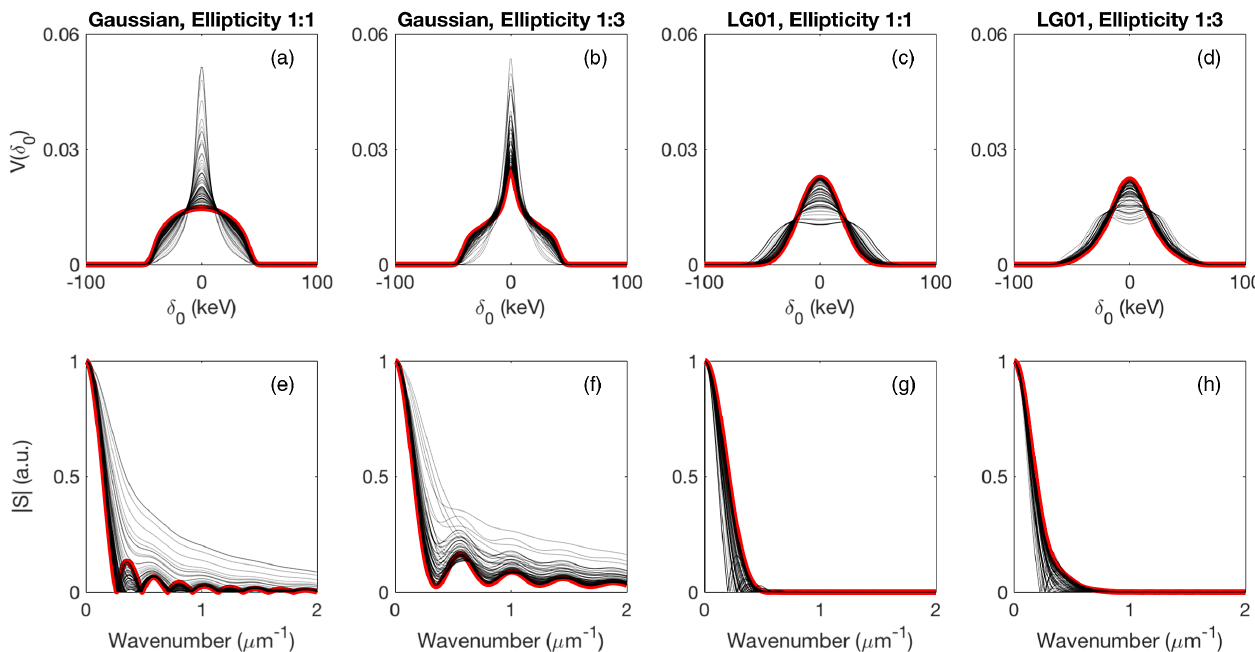
FIG. 3. Energy distributions and suppression factors for Gaussian and LG01 beams, with and without e-beam ellipticity. Parameters are set for 20 keV rms energy spread. The red line is the distribution generated when offset and pointing angle are zero. Each of the 100 superimposed distributions is generated with a random offset with identical laser and e-beam